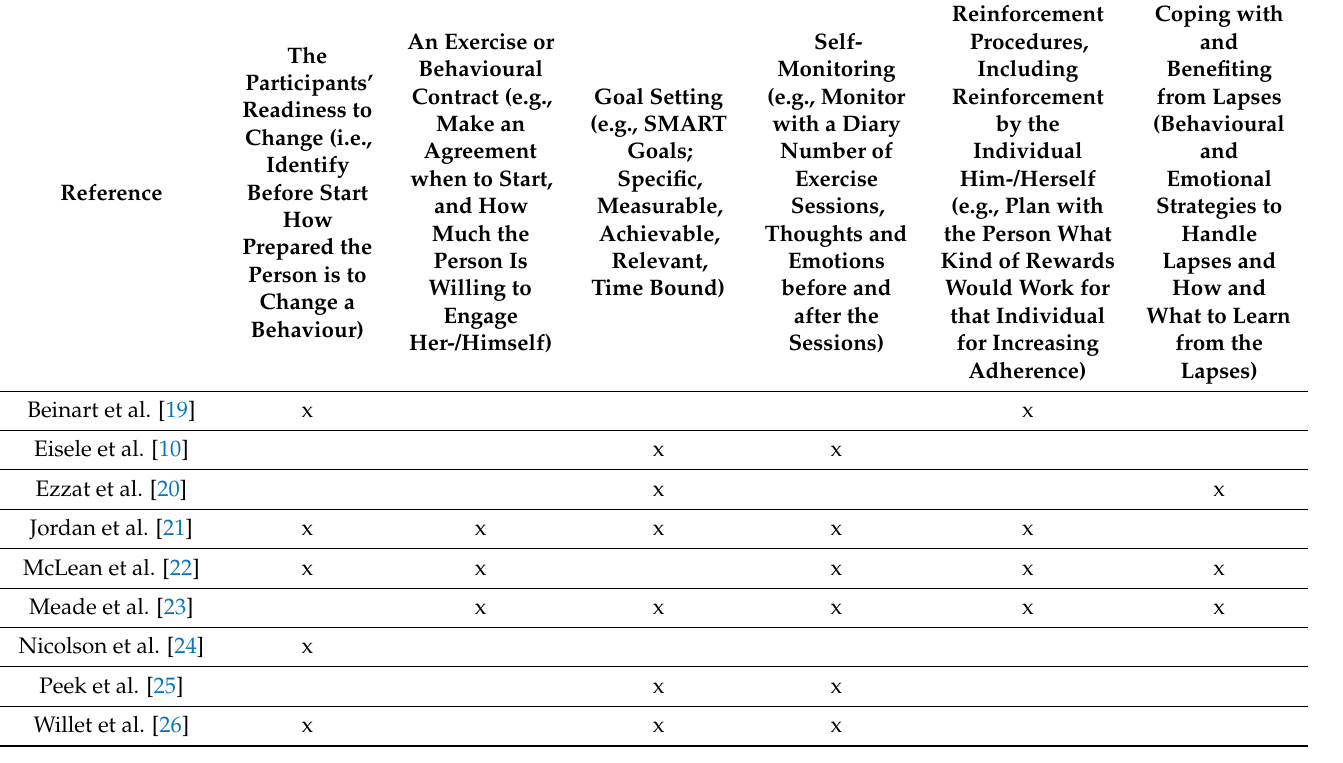
Table 4. Adherence to exercise behaviour components categorized according to the behavioural wheel provided by Michie et al. [42] regarding capability, motivation and opportunity. Motivation: Motivation includes cognitive, emotional, and reflective decision making as well as habitual processes that facilitate and direct behaviour/activity.